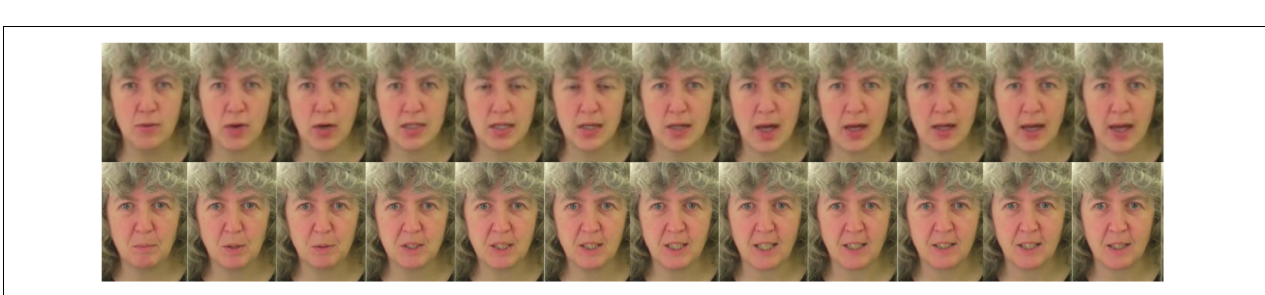
FIGURE 2 | Video preprocessing pipeline used to obtain cropped videos of the speakers’ face. Source: adapted from the GRID corpus (available at: https://doi.org/10.5281/zenodo.3625687) under CC-BY 4.0 license.